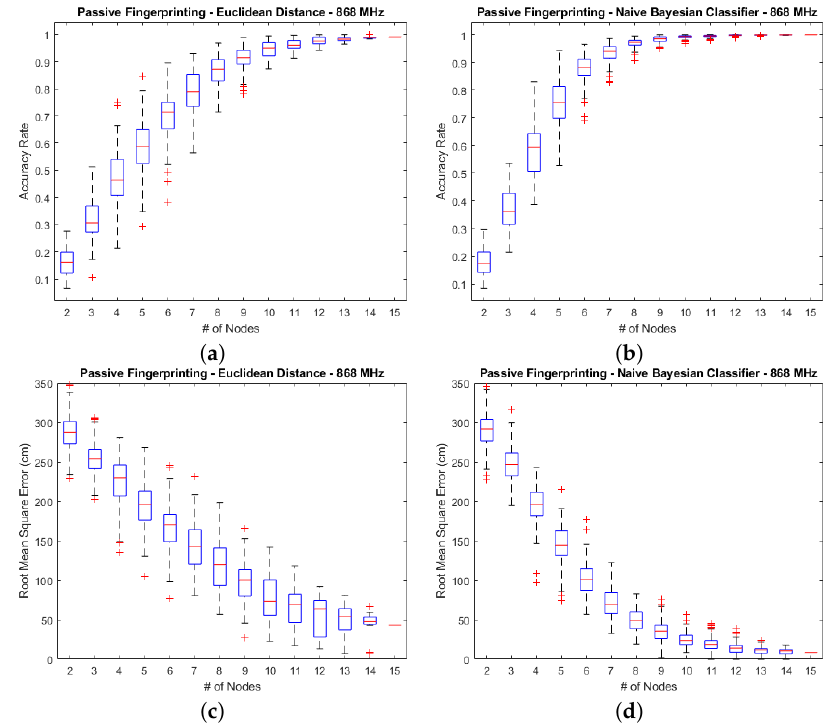
Figure 6. Box plots of the accuracy rates and root mean square distance errors based on 868 MHz data. ( a ) and ( b ) show the accuracy rates for respectively the Euclidean distance-based and naive Bayesian classifier-based methods, while ( c ) and ( d ) show the root mean square distance errors for both